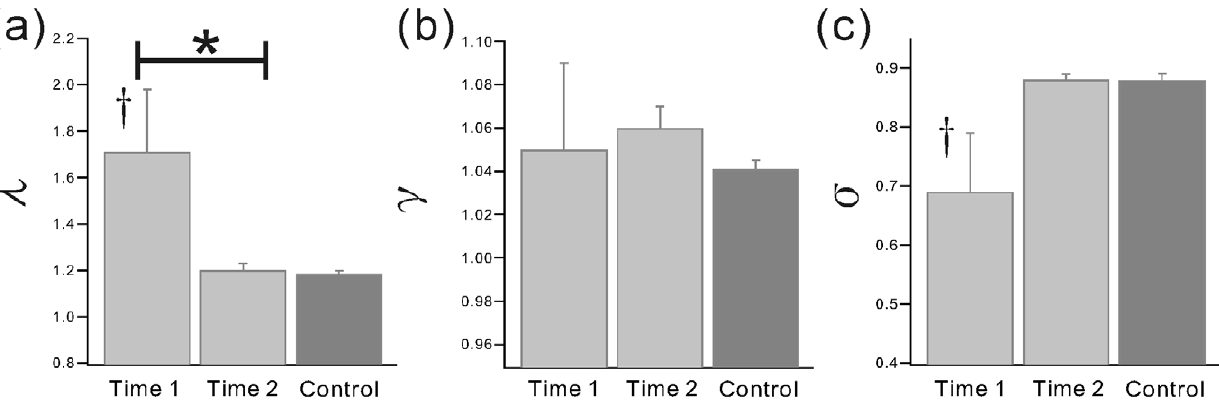
Figure 4. Functional Network properties of weighted networks (2). The weighted network properties; (a) l , (b) c , and (c) s . *indicates significant difference between Time 1 and Time 2. { indicates significant change from control group.